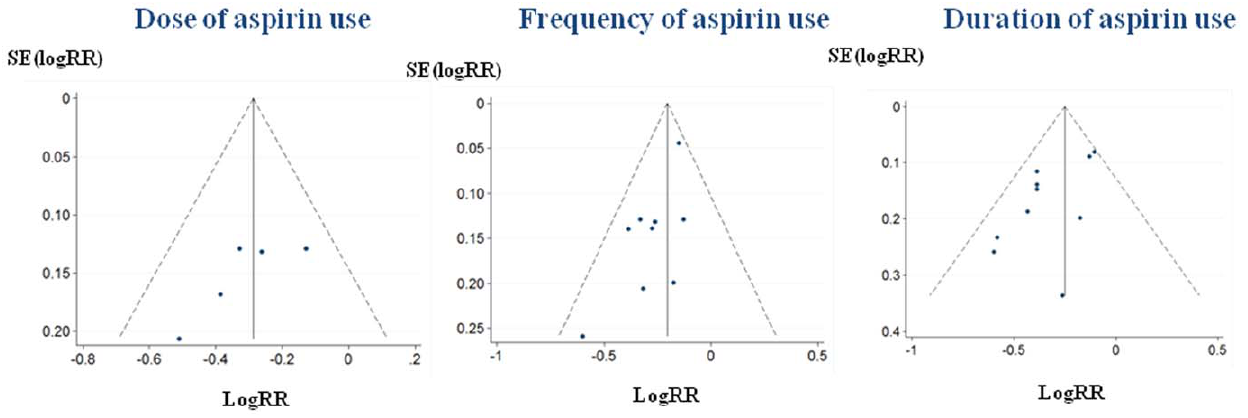
Figure 2. Begg’s funnel plot with 95% confidence limits to detect publication bias. Each point represents a separate study for the indicated association.